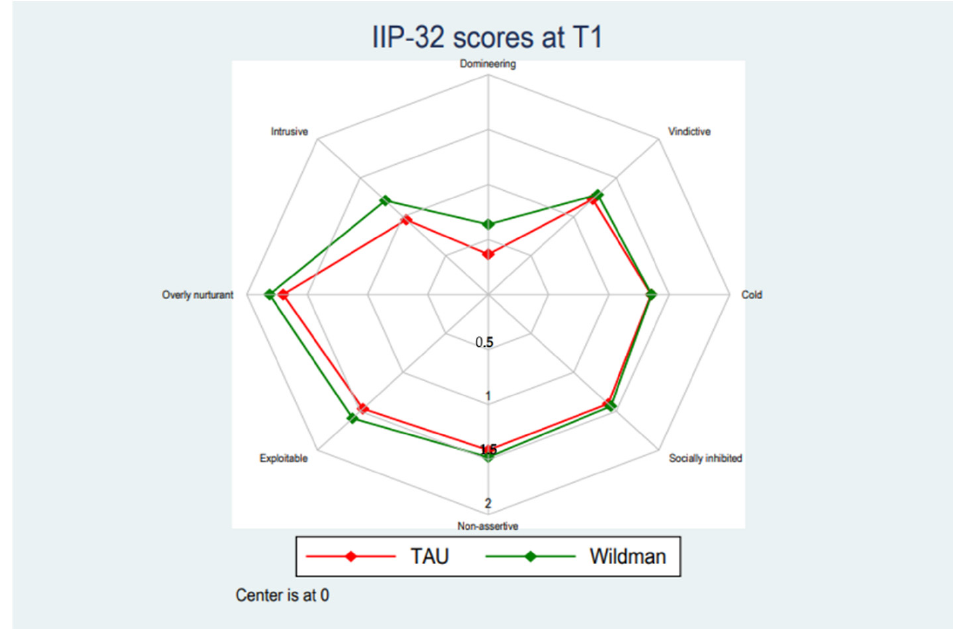
Figure 1. Baseline score pattern for TAU and the Wildman Programme-group.